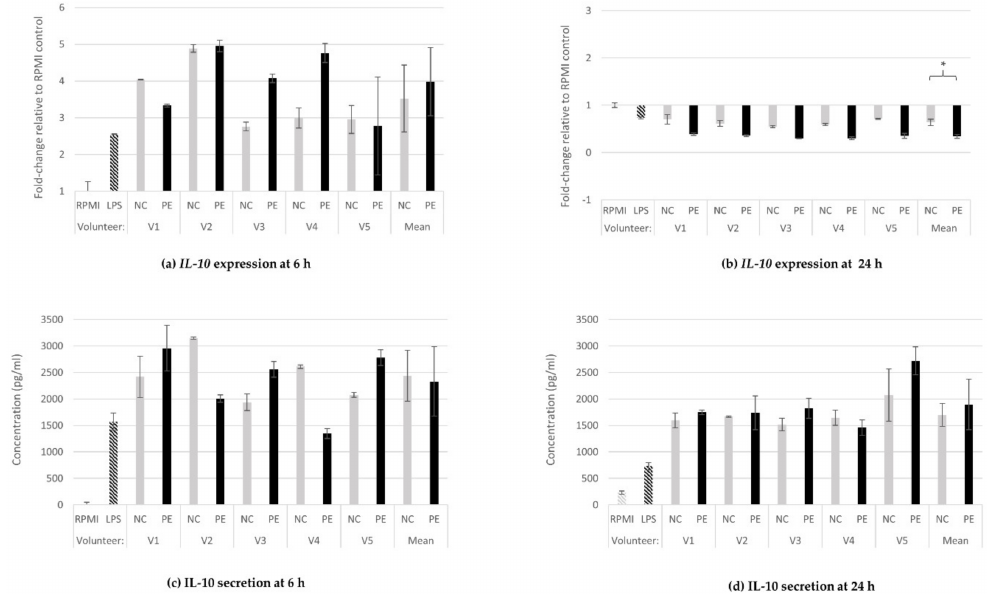
Figure 2. IL-10 gene expression and protein release. Relative gene expression of IL-10 at 6 h ( a ) and 24 h ( b ) of treatment of U937-derived macrophages with FSs, and IL-10 concentration in supernatants of the same cells at 6 h ( c ) and 24 h ( d ). Gene expression is exhibited as fold-change of the value in the untreated cells (RPMI) and relative towards GAPDH expression ( ∆∆ Ct) for all samples ( a , b ). The concentration of the cytokine is expressed in pg/mL of the cell culture supernatants ( c , d ). Data shown are the means and standard deviation (SD bars) from two technical measurements. IL-10 concentration in RPMI at 6 h was below detection levels. Asterisks indicate statistical significance as shown by paired-samples t -test, with * p < 0.05. RPMI: baseline, absence of treatment; LPS: treatment with 100 ng/mL lipopolysaccharide, positive control; NC: treatment with FSs from fermentation in the absence of additional carbon source; PE: treatment with FSs from fermentation in the presence of lyophilized mushroom powder of P. eryngii